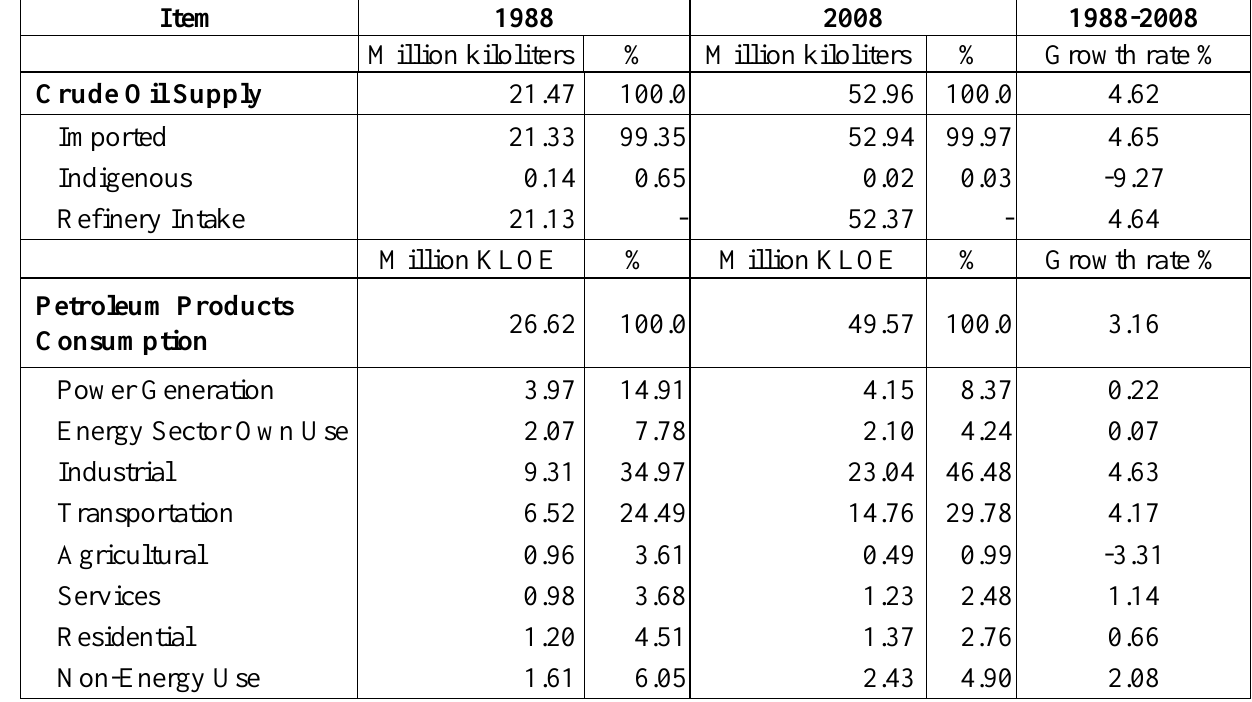
Table 3. Petroleum supply and consumption